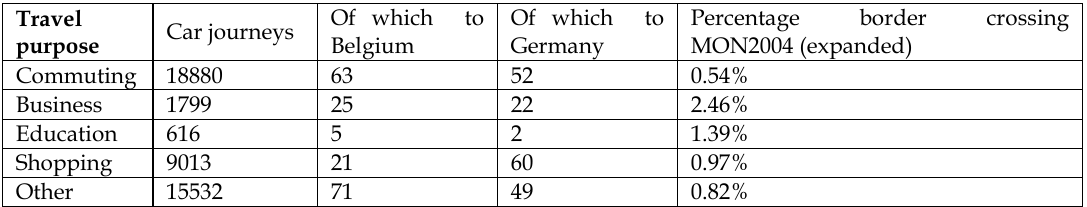
Table 2. Journeys in MON 2004/2005 by travel purpose and % border